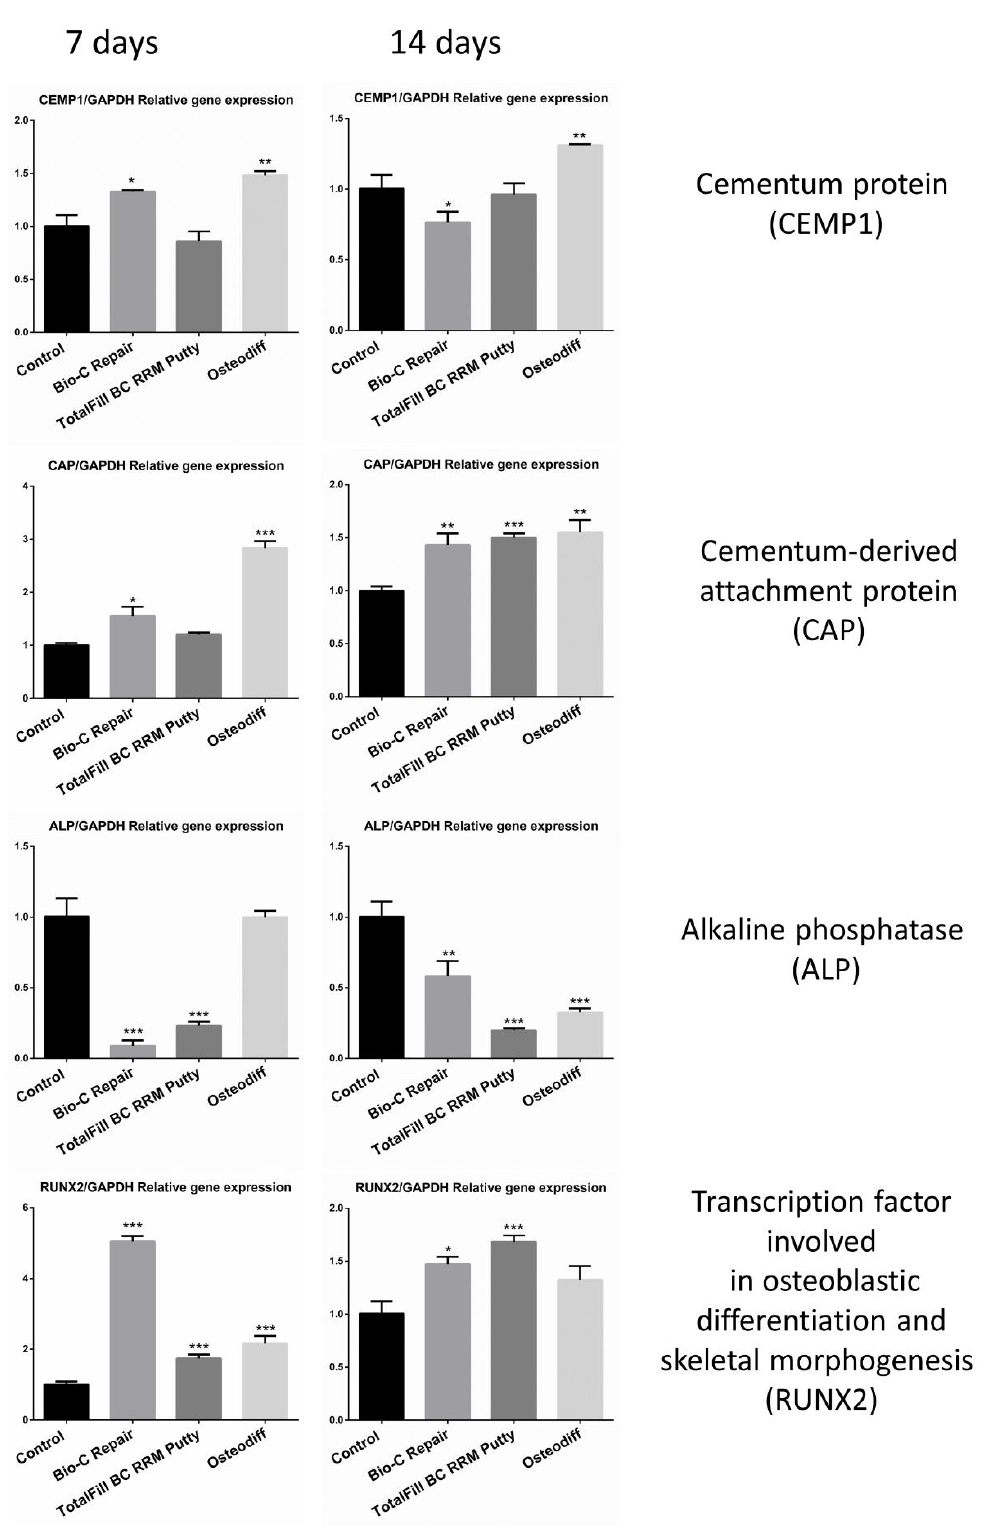
Figure 6. qPCR analysis. Gene expression profiles of hPDLSCs treated with undiluted materials showing expression of ALP, CEMP, RUNX2, and CAP genes. Values indicated with a * represent significant di ff erences between the groups. * p < 0.05, ** p < 0.01 and *** p <